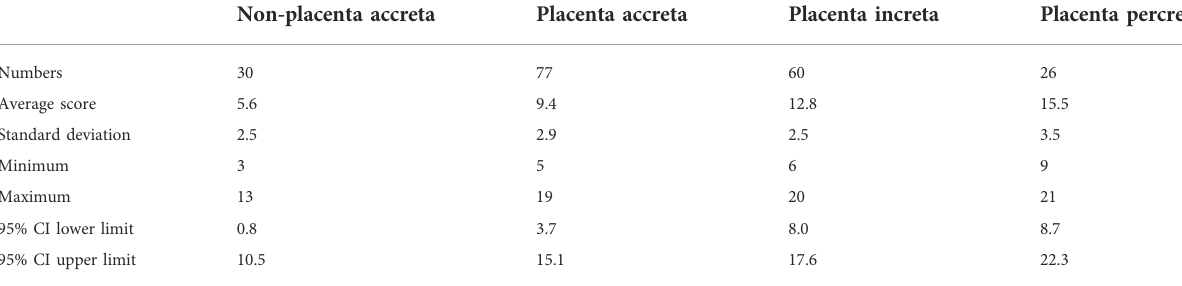
TABLE 3 Four groups of patients with their corresponding magnetic resonance imaging